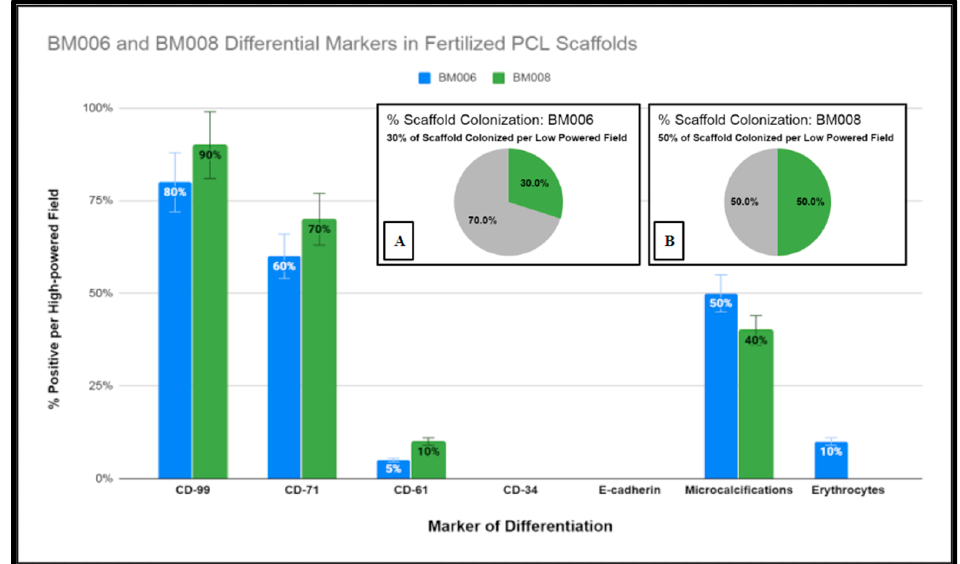
Figure 11. Graphical representation of immunohistochemical studies performed of immature hu- man bone marrow markers CD-99, CD-71, CD-61, CD-34, and E-cadherin of primary hBM seeded honeycomb infill PCL scaffold cultured for 21 days in rotating shaker culture. Insets ( A , B ) display percentages of PCL scaffolds adequately colonized by (hBM) cell populations BM006 and BM008 for histological analysis.